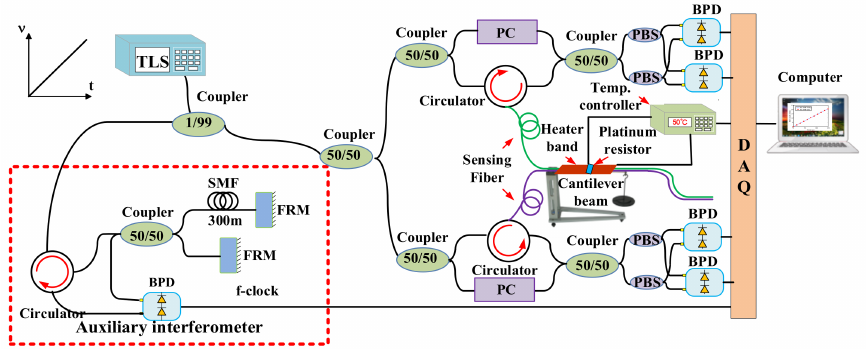
Figure 18. Experimental setup for distributed strain and temperature discrimination method using two types optical fiber in OFDR. TLS is tunable laser source. FRM is Faraday rotating mirror. PC is polarization controller. BPD is balanced photo-detector. DAQ is data acquisition card. The two types of sensing fiber standard SMF and RC SMF are paired side by side as FUT (reprinted from Ding et al. [52] with permission of IEEE; copyright